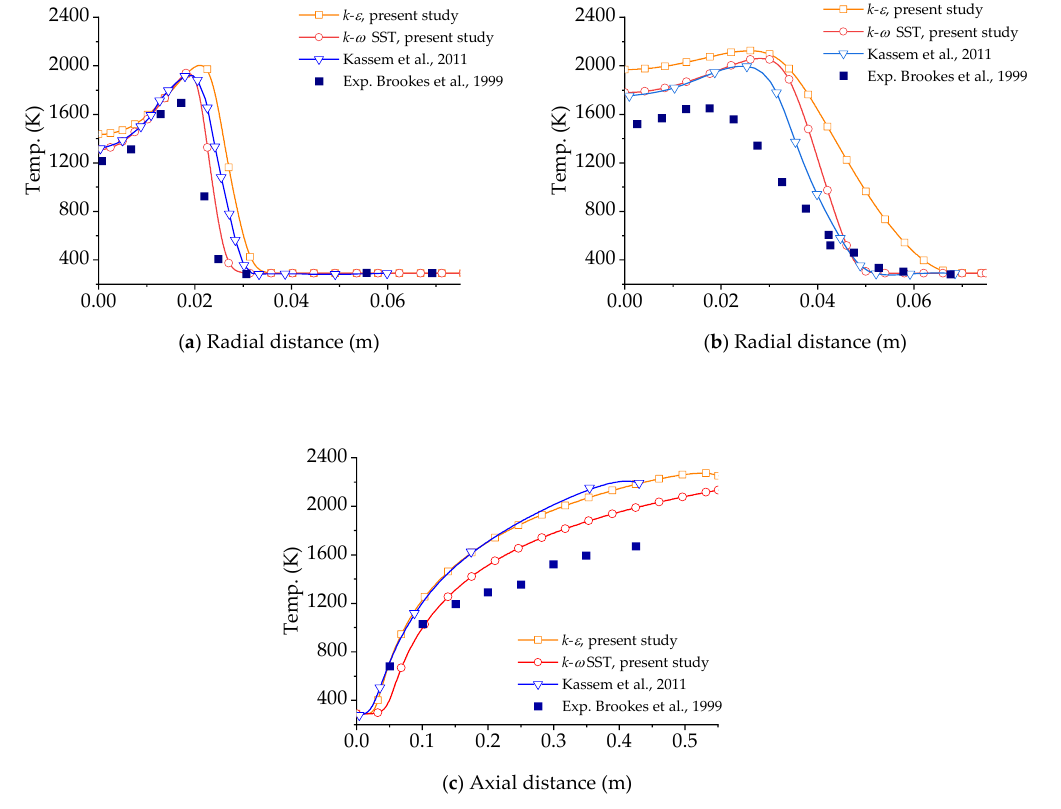
Figure 4. Temperature profiles at the height of ( a ) h = 0.15 m; ( b ) h = 0.30 mm; and ( c ) along the axial direction [7,9].